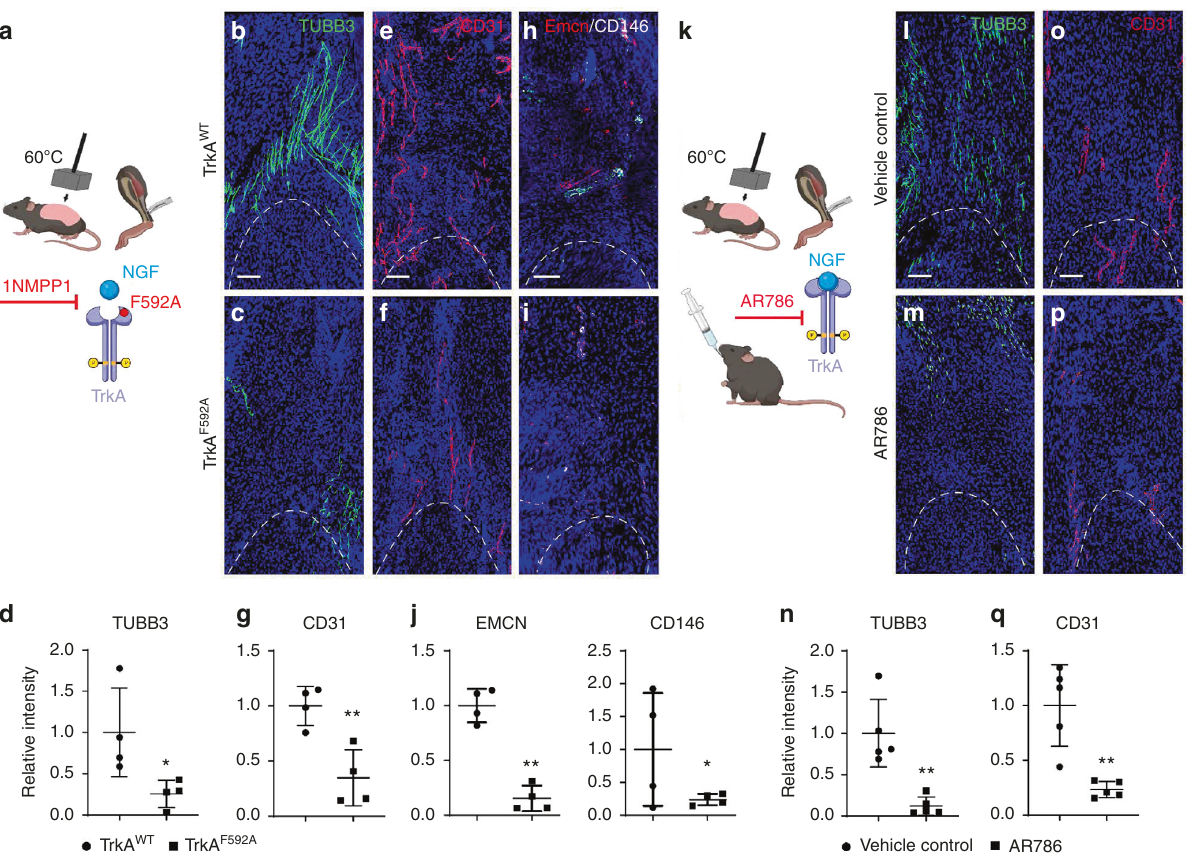
Fig. 4 Genetic and pharmacological inhibition of TrkA signaling impairs vascular ingrowth after soft tissue trauma. a Schematic representation of experiment. (Created in Biorender.com). TrkA F592A mice have a point mutation which renders them susceptible to temporally controllable inhibition of TrkA catalytic activity, via administration of the small molecule 1NMPP1. Either TrkA WT or TrkA F592A animals (6 – 8 weeks old, male and female mice) were subjected to HO induction and both administered 1NMPP1 throughout the study period. Analyses performed at 21 d post-injury. b – d Representative immunohistochemical staining for TUBB3 (Beta III Tubulin, appearing green) and quanti fi cation among TrkA WT or TrkA F592A animals, as assessed at the distal tenotomy site as visualized using sagittal cross- sections. e – g Representative immunostaining for CD31 (appearing red) and quanti fi cation among TrkA WT or TrkA F592A animals. h – j EMCN (Endomucin) and CD146 co-immunohistochemical staining (appearing red and white) and quanti fi cation among TrkA WT or TrkA F592A animals. k Schematic representation of experiment. C57BL/6 J mice (6 – 8 weeks old, male and female mice) were administered AR786 or vehicle control throughout the study period. HO induction was performed (burn/tenotomy), with analysis at day 21. l – n Representative immunohistochemical staining for TUBB3 and quanti fi cation among control or AR786 treated animals, as assessed at the distal tenotomy site. o – q Representative immunostaining for CD31 (appearing red) and quanti fi cation among control or AR786 treated animals. Dashed white lines indicate edges of Achilles tendon. Scale bars: 100 μ m. n = 4 – 5 animals per group. Individual dots in scatterplots represent values from single animal measurements, while mean and one SD are indicated by crosshairs and whiskers. * P < 0.05; ** P < 0.01. A two-tailed student ’ s t test was used for all